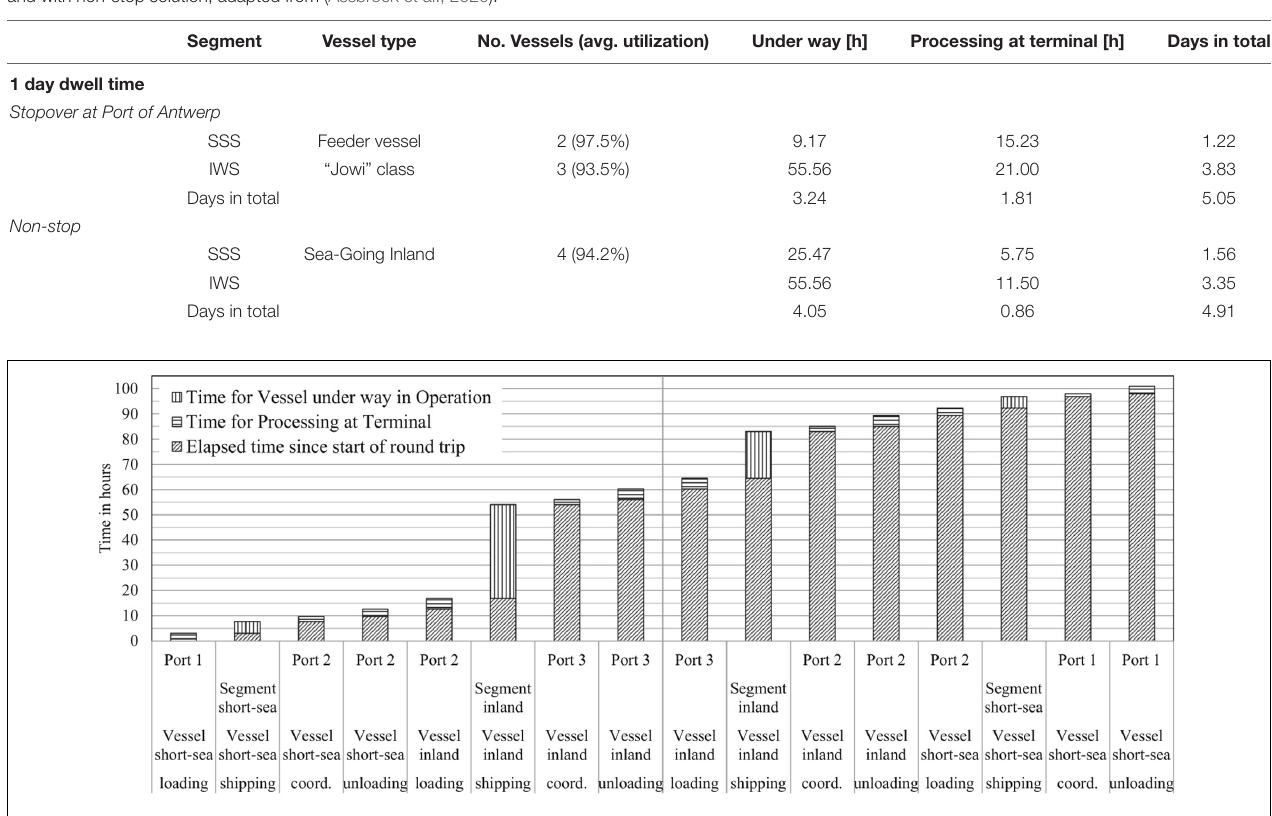
FIGURE 7 | Split of durations for individual operations (hatched horizontally in port and vertically under way) along a round trip between the transport and logistics hub and NRW with a feeder and large inland vessel (Jowi). The cumulative sum shows the elapsed time (hatched diagonal) until the current operation (from left to right). Vessels are heading upstream/inbound first, left of the vertical line that indicates half way, and downstream on the way back (Assbrock et al.,